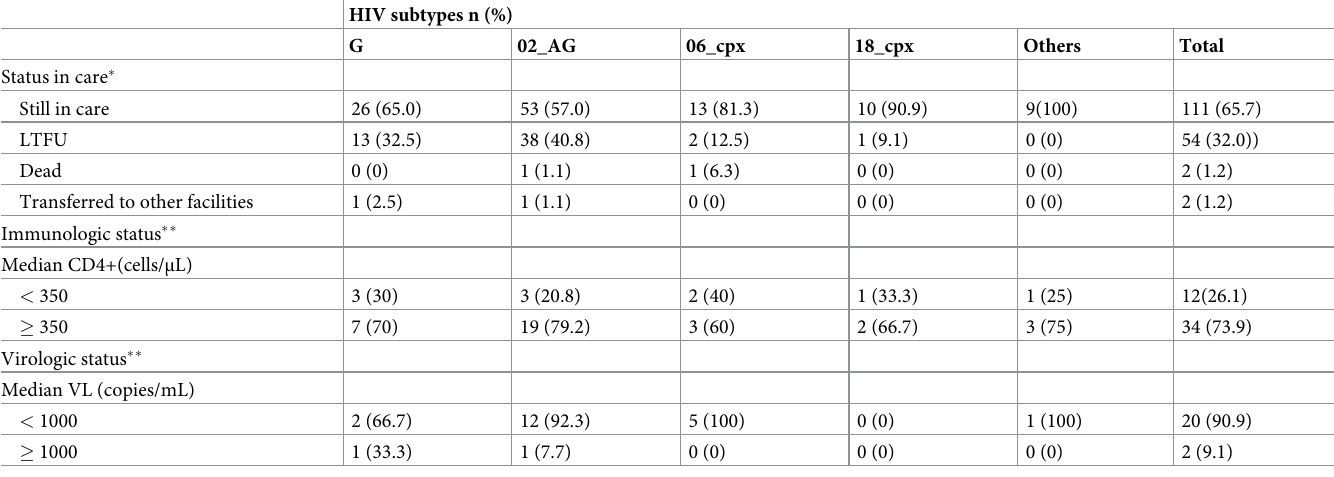
Table 4. Outcome at 60th months of follow-up of each patient from time of initiation of ARV.